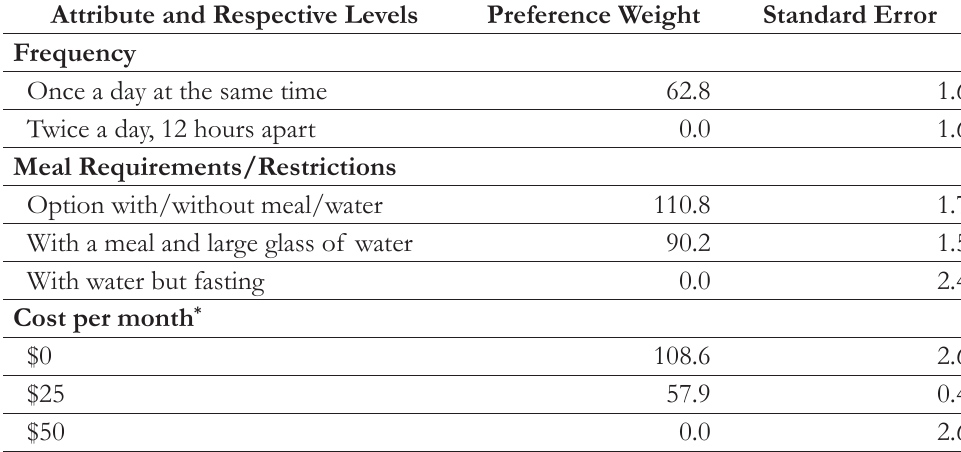
Table 2. Mean Preference Weights for each Attribute Level Attribute and Respective Levels Preference